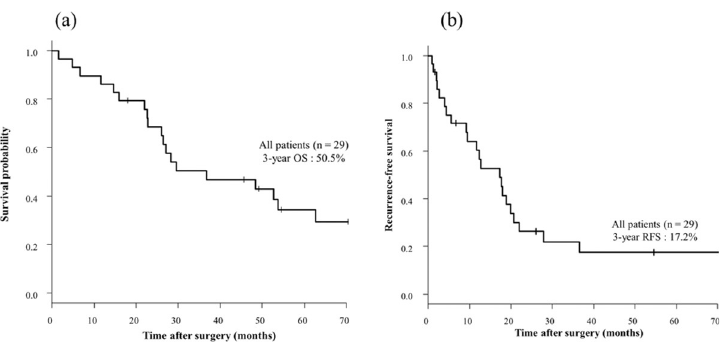
Fig 2. Kaplan-Meier overall survival (a) and recurrence-free survival (b) curve for all patients. The 3-year OS rate was 50.5% (Fig 2A), and the 3-year RFS rate was 17.2% (Fig 2B). OS, overall survival; RFS, recurrence-free